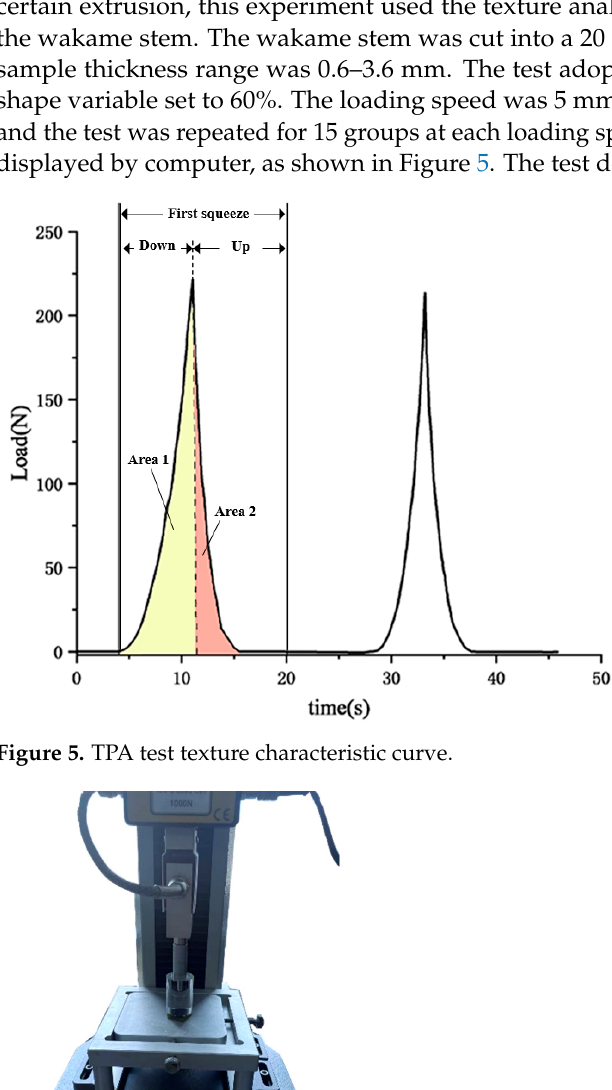
Figure 4. Schematic diagram of tensile test device.